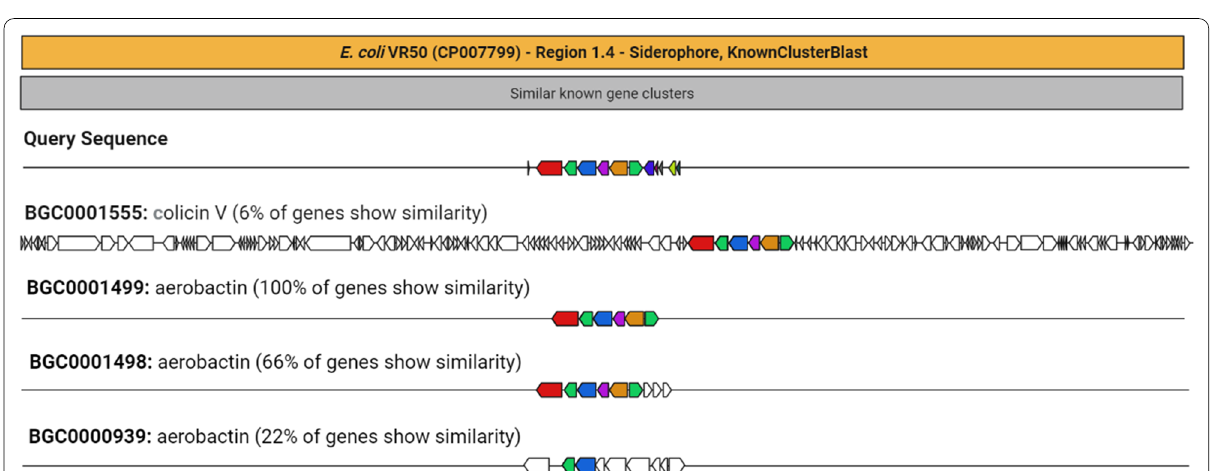
Fig. 7 Similar gene clusters compared to E. coli VR50 siderophore biosynthesis gene